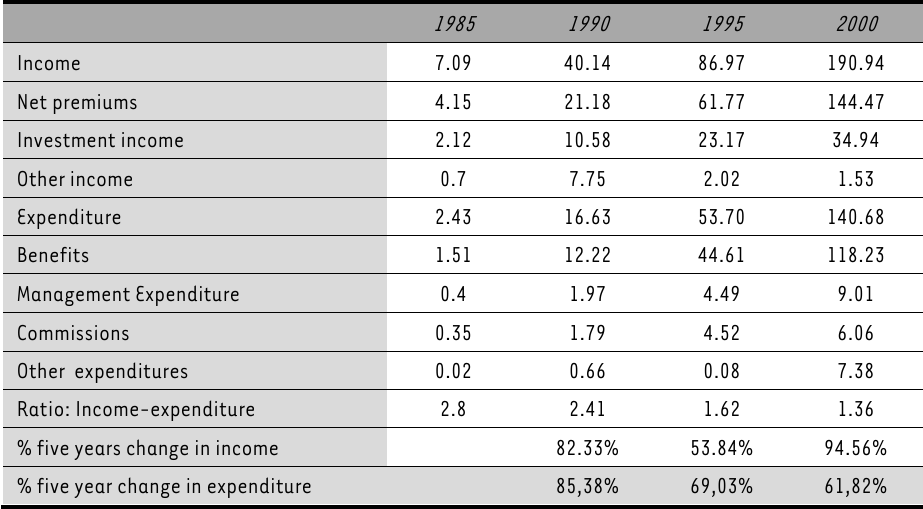
Income and expenditures of long-term insurance companies, 1985-2000 (R’bn)